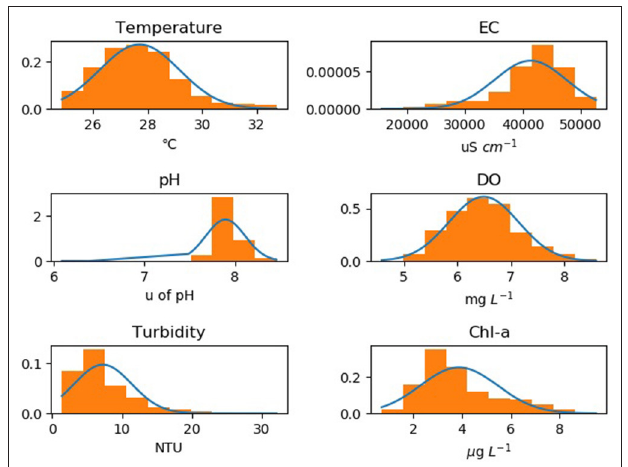
FIGURE 2 | Histogram of 6 physiochemical parameters.